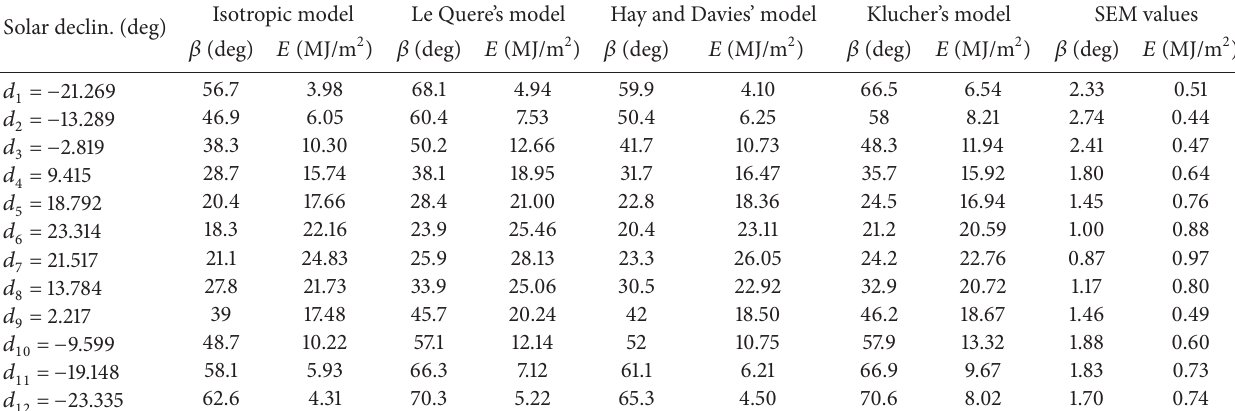
in Section 2 applied to the monthly averages of the daily global horizontal solar irradiation data acquired from 1985 to 1989 at the site of Paris (latitude +48 ∘ 51 󸀠 N; longitude +2 ∘ 20 󸀠